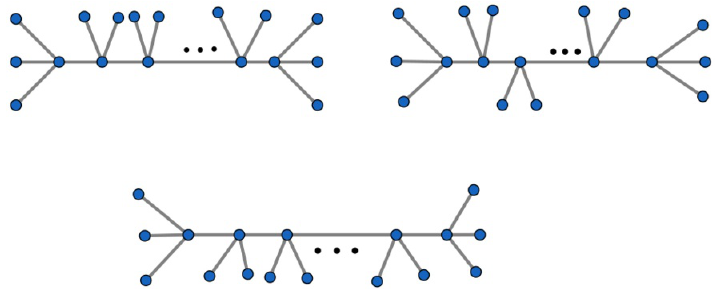
Figure 14 . All the diagrams that have associahedra as their